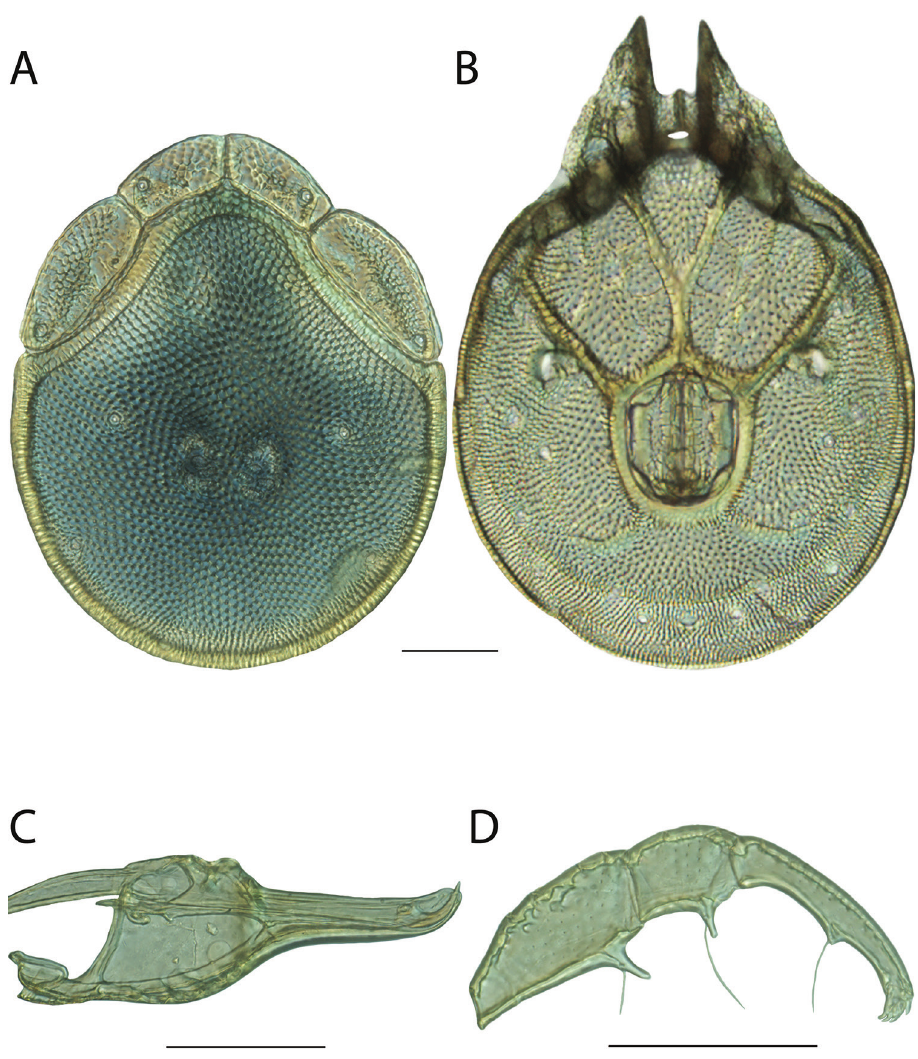
Figure 213. Torrenticola raptor sp. n. male: A dorsal plates B venter (legs removed) C subcapitulum D pedipalp (setae not accurately depicted). Scale = 100